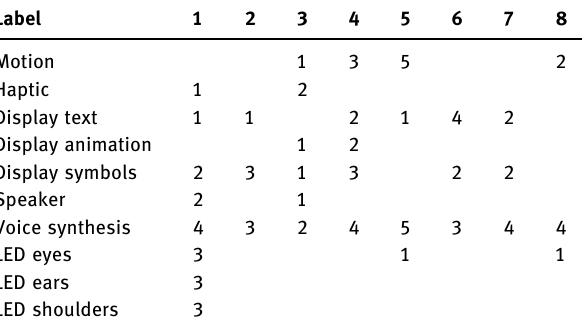
Table 1: The design labelsused inthe interview phase, bythe number of participants, across the eight